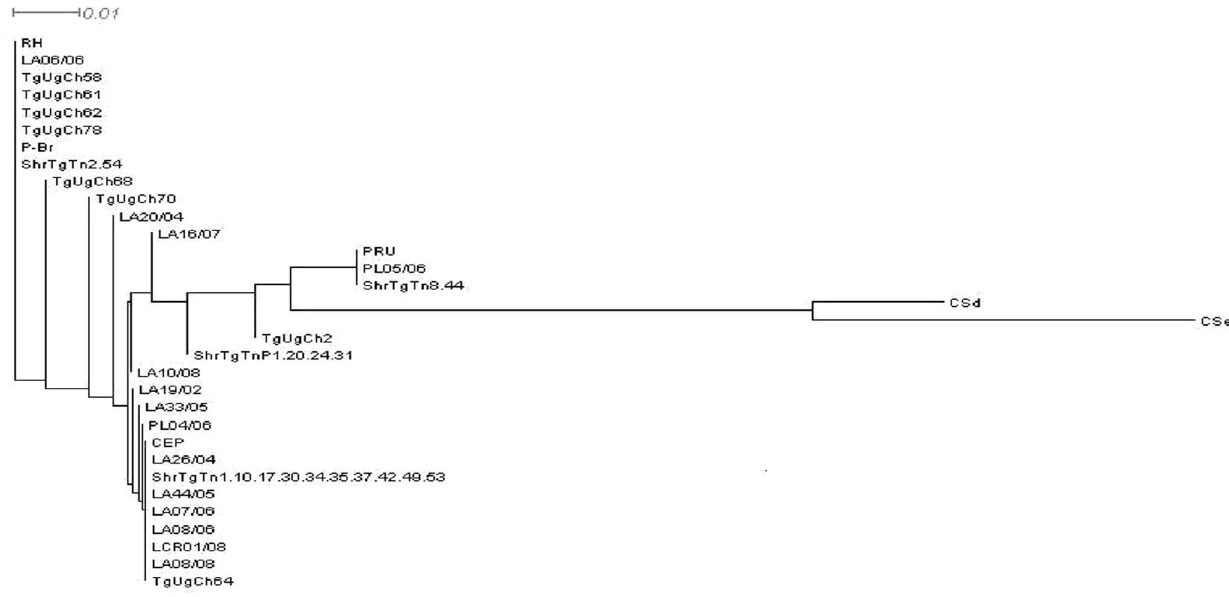
Figure 2. SplitsTree network of toxoplasmic strains at the marker SAG3. RH, PRU and CEP represent reference strains of type I, II and III respectively. TgUgCh: strains isolated form free-ranging chicken in Uganda. LA, PL, LCR: Tunisian clinical strains. ShrTgTn: strains isolated from sheep in Tunisia. CSe and CSd: atypical strains.